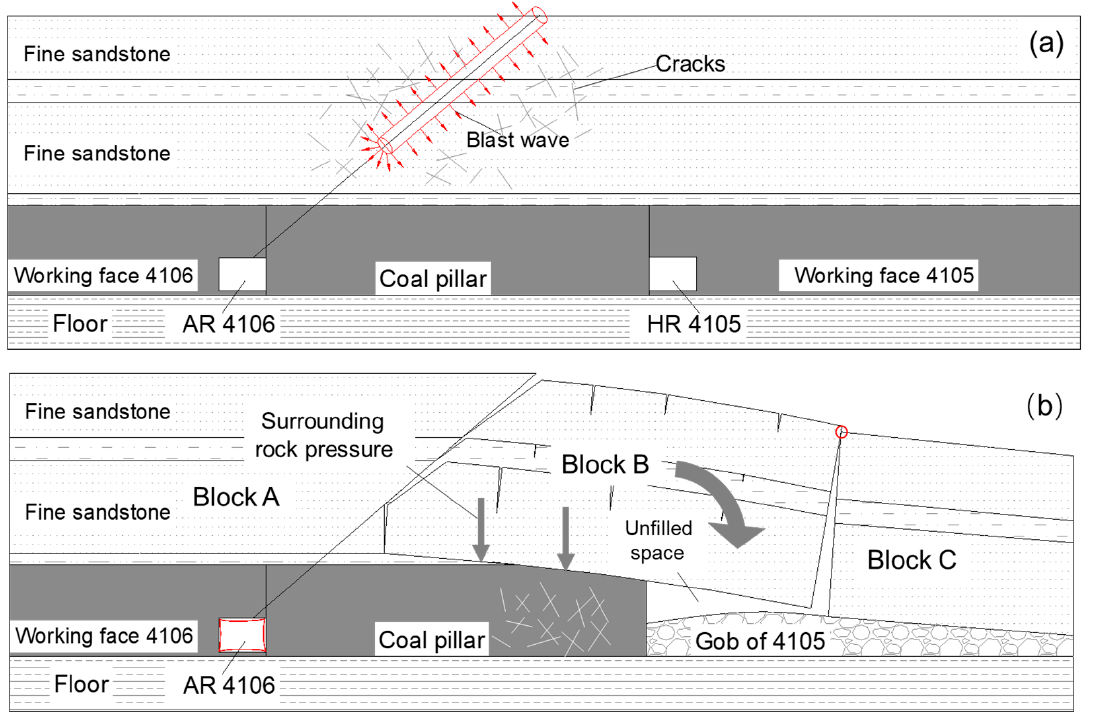
Figure 15. Schematic diagram of pressure relief by deep-hole blasting: ( a ) blasting weakens the strength of rock mass around the borehole and ( b ) lateral masonry beam structure of stope after mining of adjacent working face.